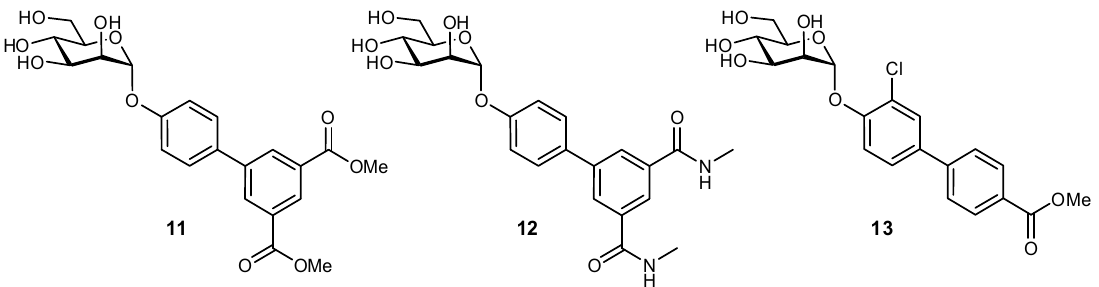
Figure 5. Biaryl mannosides have been successfully developed as nanomolar antagonists of the bacterial protein FimH [56,60].